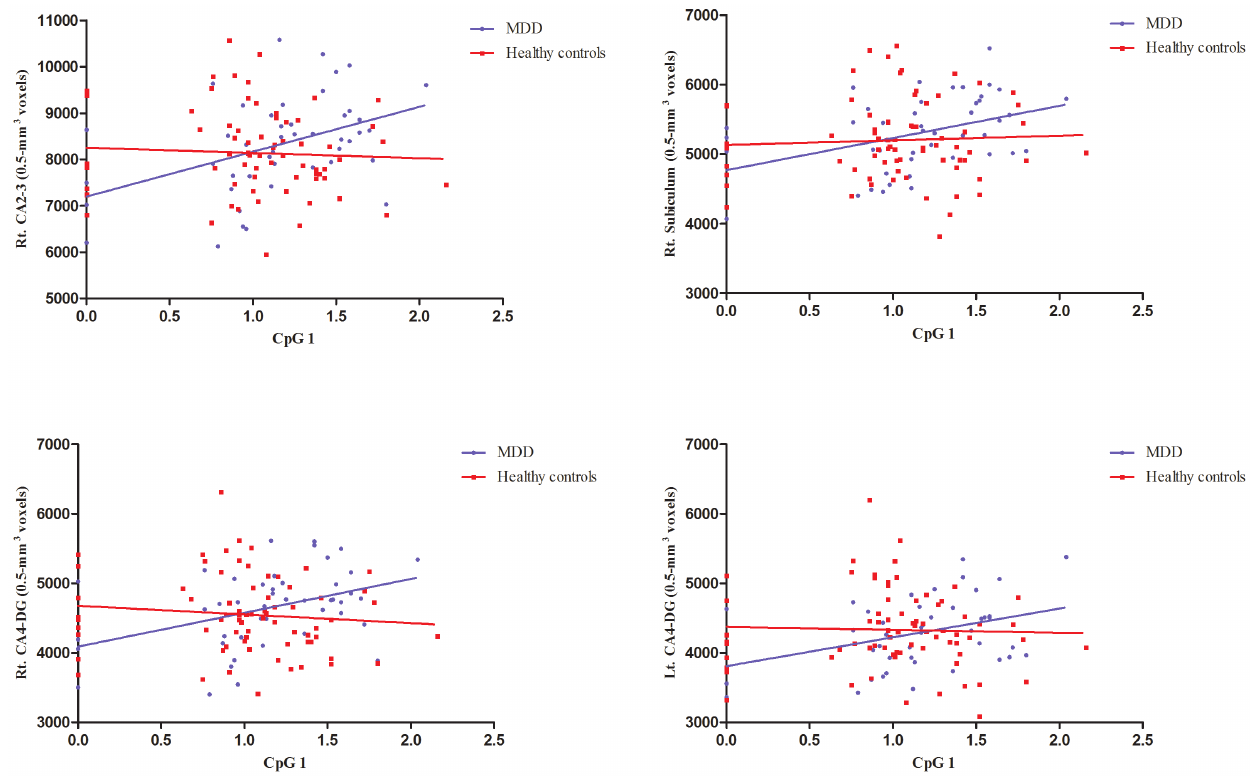
Figure 5. Correlations between NR3C1 methylation at CpG1 and hippocampal subfield volumes among participants.